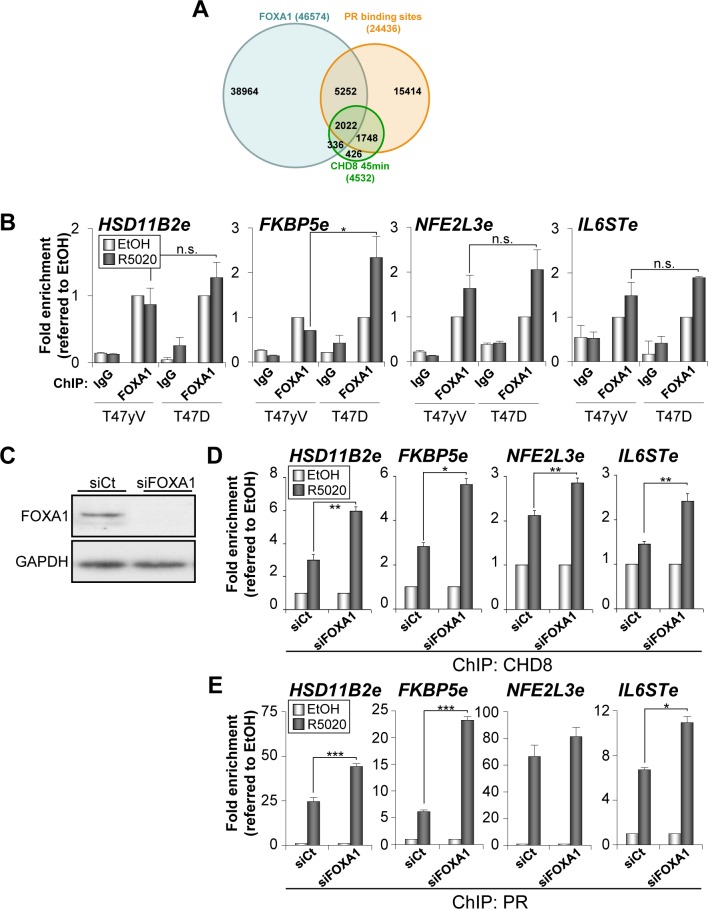
Depletion of FOXA1 stimulates PR and CHD8 recruitment to PRbs.(A) Overlapping between progesterone-dependent CHD8 binding sites (green), progesterone-dependent PRbs (red) [25] and FOXA1 binding sites (blue) in T47D cells (ENCODE dataset GSM803409). (B) ChIP analysis of FOXA1 occupancy at the indicated enhancers in T47-YV or T47D-MTVL cells stimulated with R5020 (R5020) or vehicle (EtOH) for 45 min. (C) Western blot analysis of FOXA1 expression upon transfection of T47D-MTVL cells with control siRNA (siCt) or siRNA against FOXA1 (siFOXA1). (D-E) ChIP analysis of CHD8 (D) and PR (E) at the indicated enhancer in T47D-MTVL cells transfected with control siRNA (siCt) or siRNA against FOXA1 (siFOXA1), and then stimulated with R5020 (R5020) or vehicle (EtOH) for 45 min. (B, D-E) Data are the mean of at least n = 6 qPCR reactions from three independent experiments. Error bars represent ± SD values. * p < 0.01; ** p < 0.001; *** p < 0.0001 using Student’s t-test; n.s., not significant.